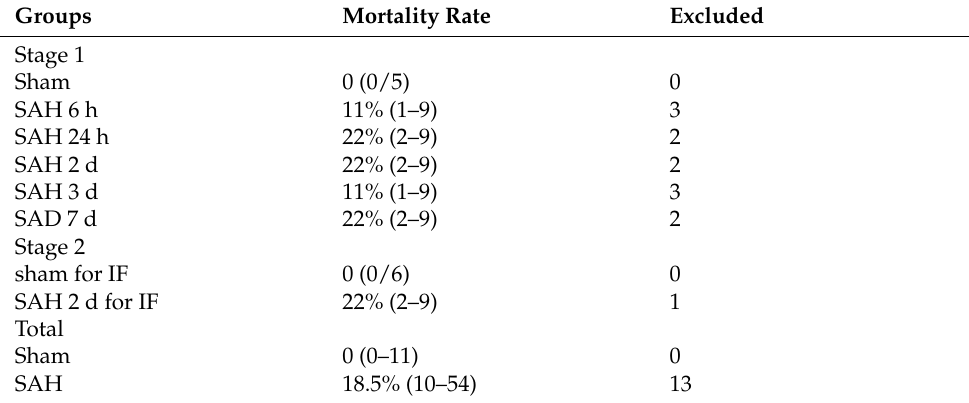
Table 3. Mortality and